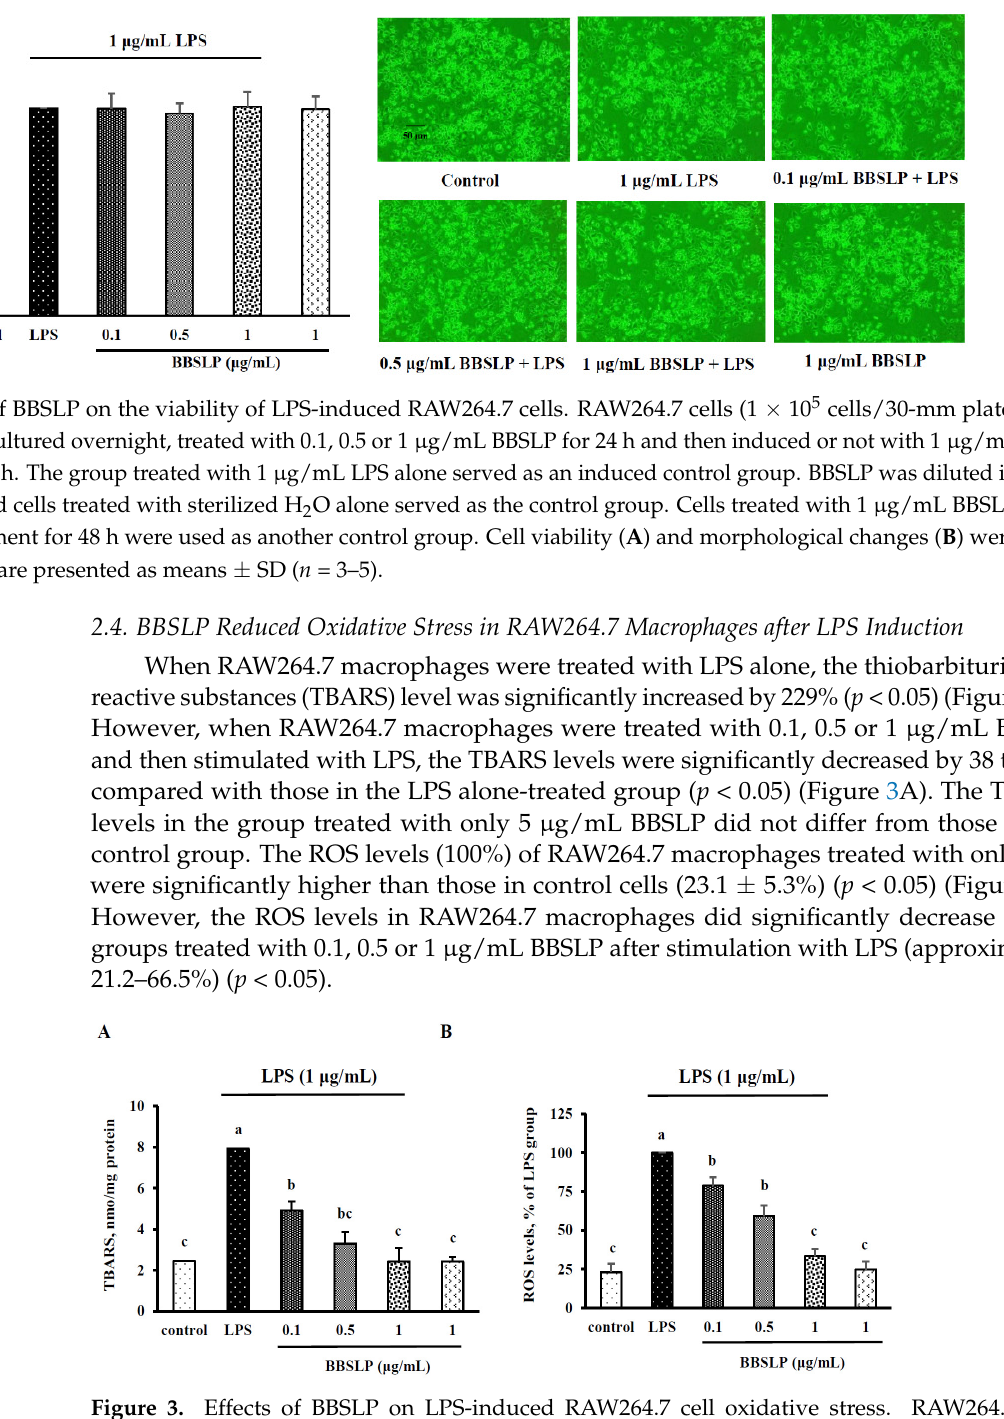
Figure 3. Effects of BBSLP on LPS-induced RAW264.7 cell oxidative stress. RAW264.7 cells (1 × 10 5 cells/30-mm plate) were seeded and cultured overnight, treated with 0.1, 0.5 or 1 μ g/mL BBSLP for 24 h and then induced or not with 1 μ g/mL LPS for another 24 h. The group treated with 1 μ g/mL LPS alone served as an induced control group. BBSLP was diluted in sterilized H 2 O, and cells treated with sterilized H 2 O alone served as the control group. Cells treated with 1 μ g/mL BBSLP